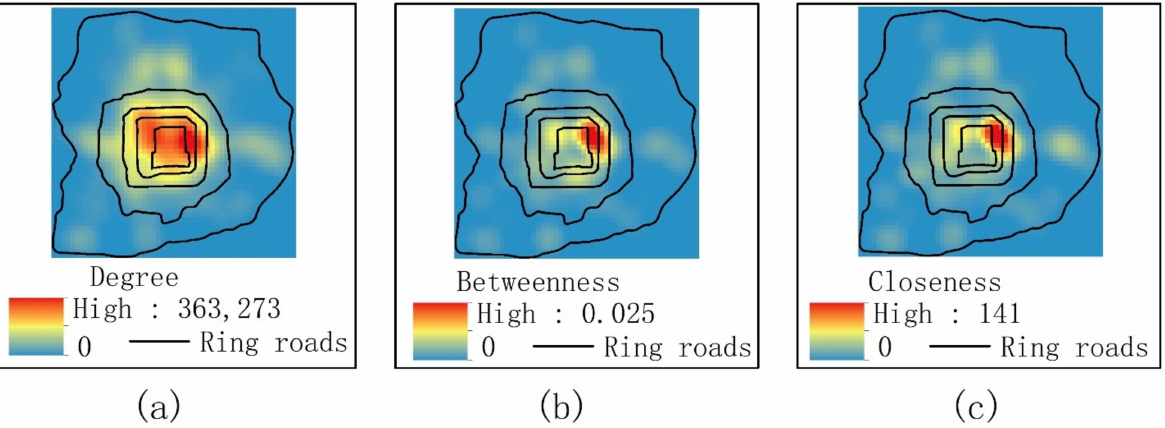
Figure 4. Spatial distributions of three weighted centrality indices of the total flow network: ( a ) degree; ( b ) betweenness; ( c )